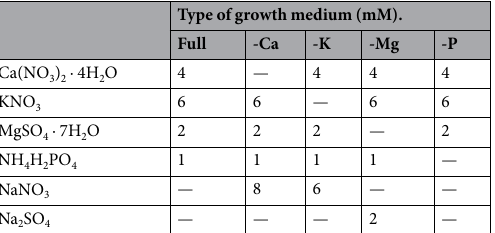
Table 3. The composition of the various culture media used in the